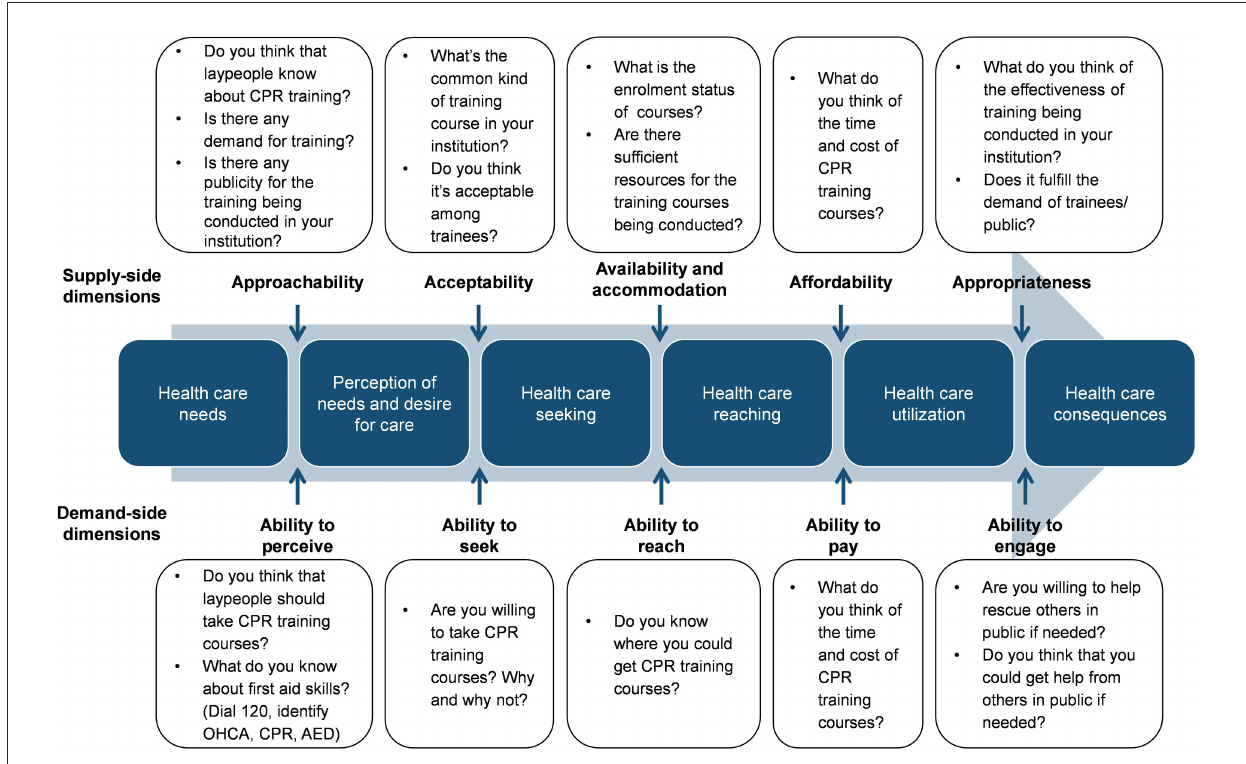
FIGURE1 Key questions for demand- and supply-side interviews. CPR, cardiopulmonary resuscitation; 120, the universal number for emergency care and first aid in China; OHCA, out-of-hospital cardiac arrest; AED, automated external defibrillator. Reproduced from Levesque JF et al. licensed under CC BY 2.0,